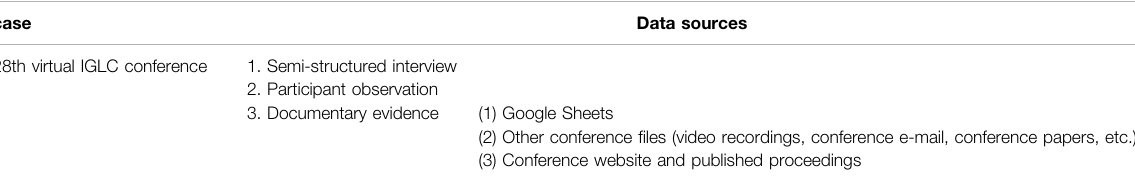
TABLE 2 | Case data sources and codes.